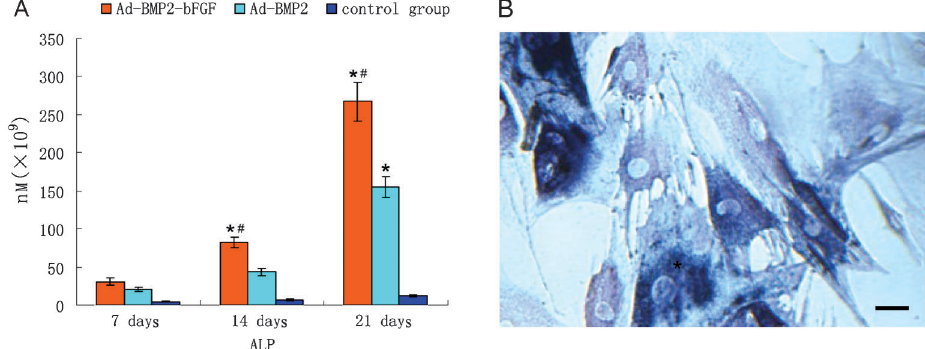
Figure 6. Alkaline phosphatase (ALP) activity in bone marrow progenitor cells (BMPCs). A , ALP activity detected in BMPCs at different days after infection. *P , 0.05 vs control. # P , 0.05 vs Ad-BMP2-infected BMPCs. B , ALP staining of BMPCs 21 days after infection with Ad-BMP2-bFGF. Many brown-black particles appeared in the cytoplasm, and cells were stained blue. Bar = 100 m m.